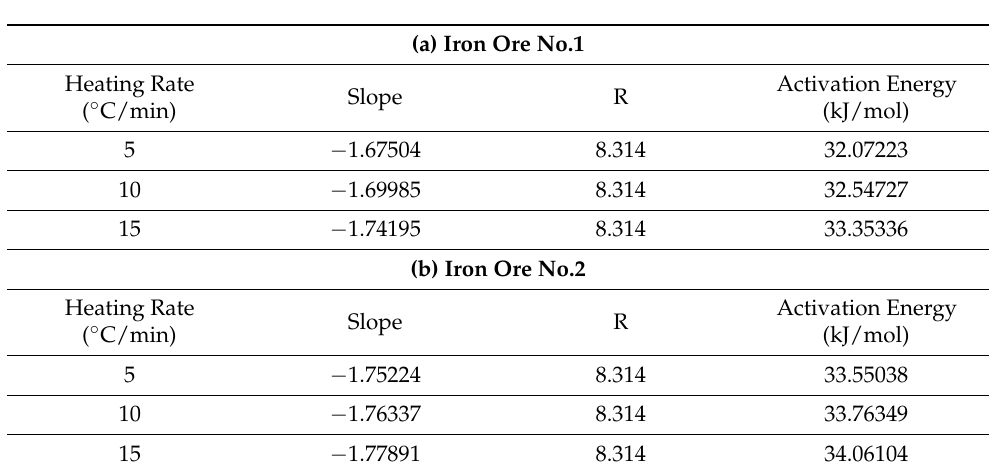
Table 5. TGA Kinetics.